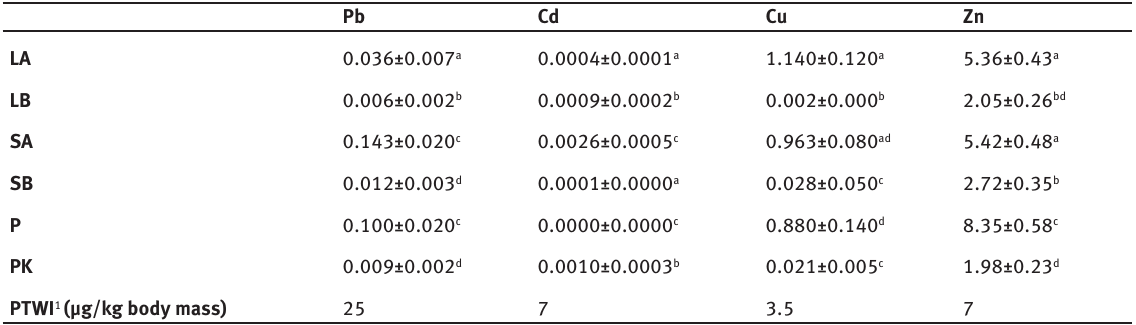
Table 6: Content of lead, cadmium, copper and zinc [mg/kg product] in cream from various regions of Poland. Pb